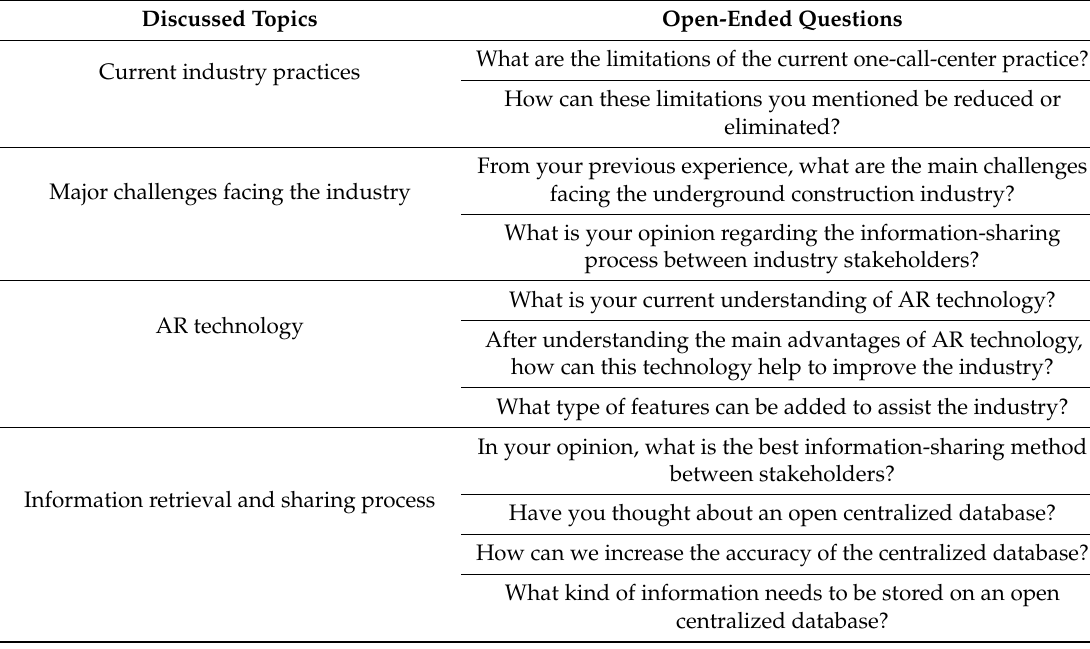
Table 1. Exploratory focus group open-ended